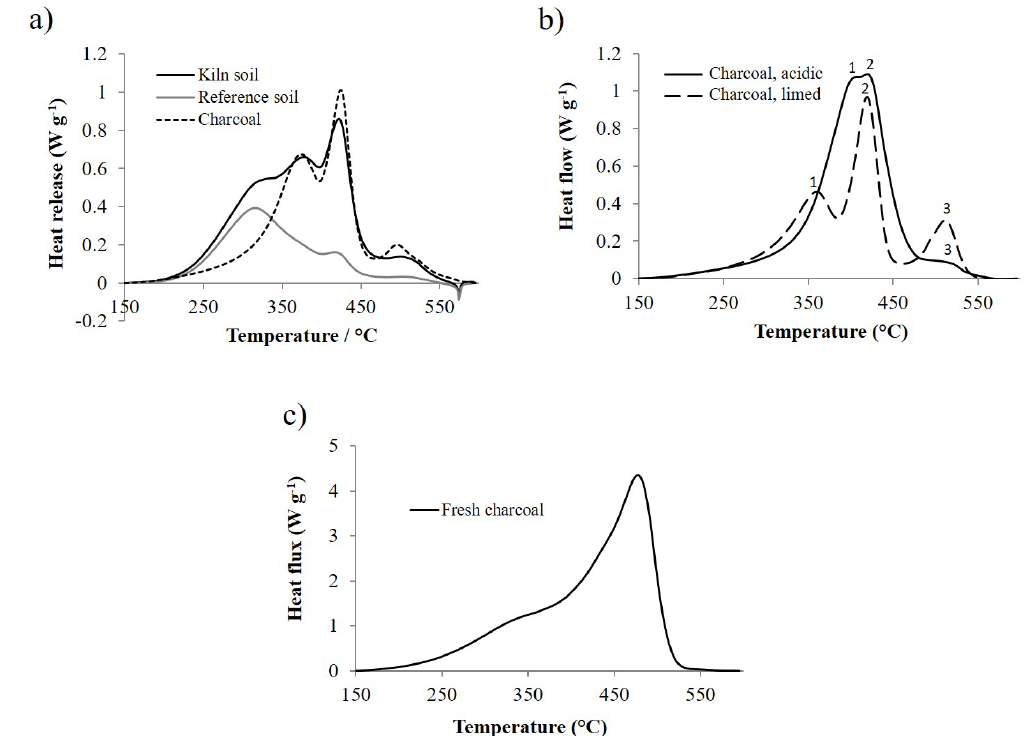
Figure 5. Differential scanning calorimetry thermograms of several charcoal samples: (a) thermogram of charcoal particles superimposed on the thermogram of the soil of the pre-industrial charcoal kiln site from which particles were extracted and on the thermogram of adjacent reference soil (adapted from Hardy et al., 2017a); (b) thermograms of charcoals extracted from an acidic forest soil and from a limed cropland soil. Numbers on the graph identify the maxima of exothermic peaks specific to the combustion of charcoal; (c) thermogram of birch charcoal that was not aged in soil (produced in a traditional mound kiln).